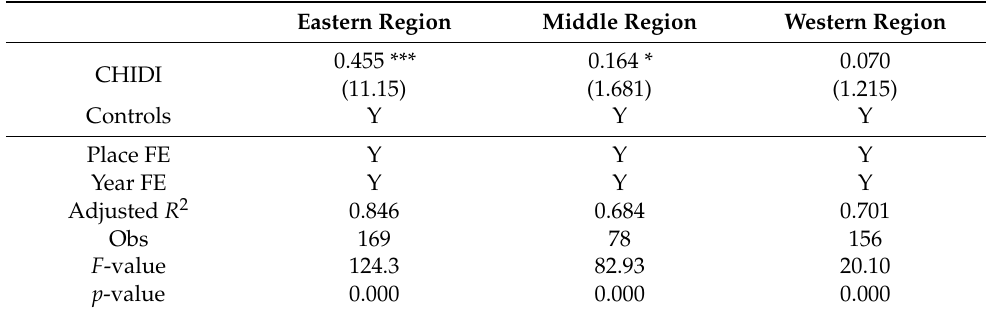
Table 5. Heterogeneity